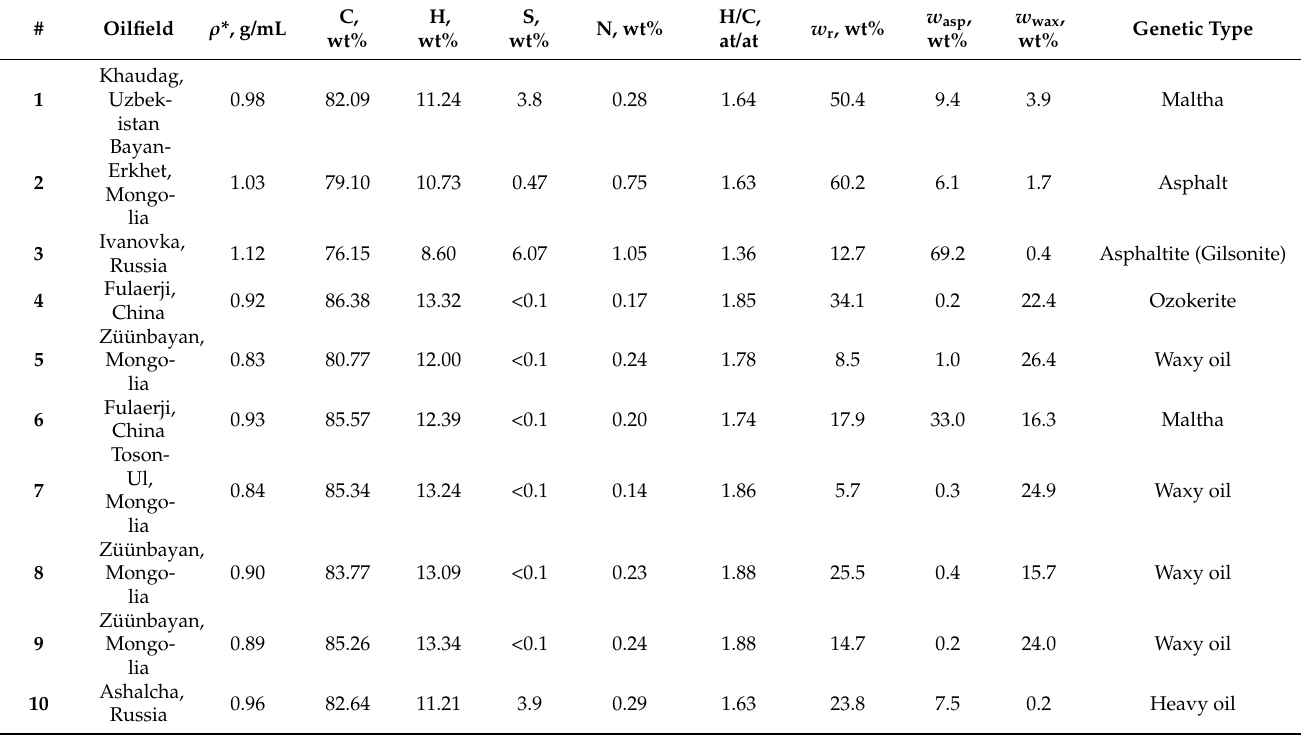
Table 1. Basic characteristics of natural heavy hydrocarbons under study.